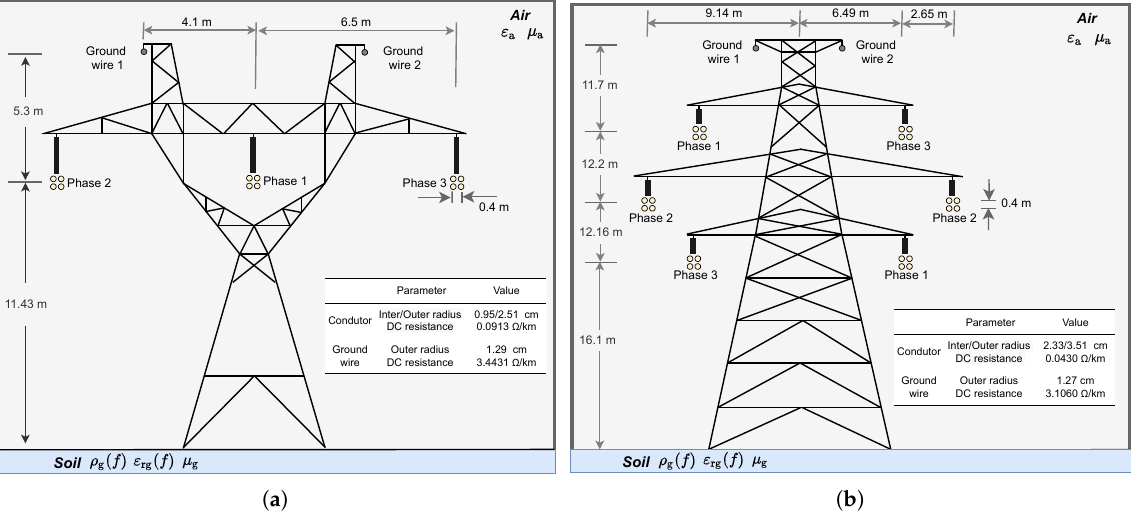
Figure 6. Single-circuit three-phase transmission line: ( a ) Geometry; ( b ) Simulation